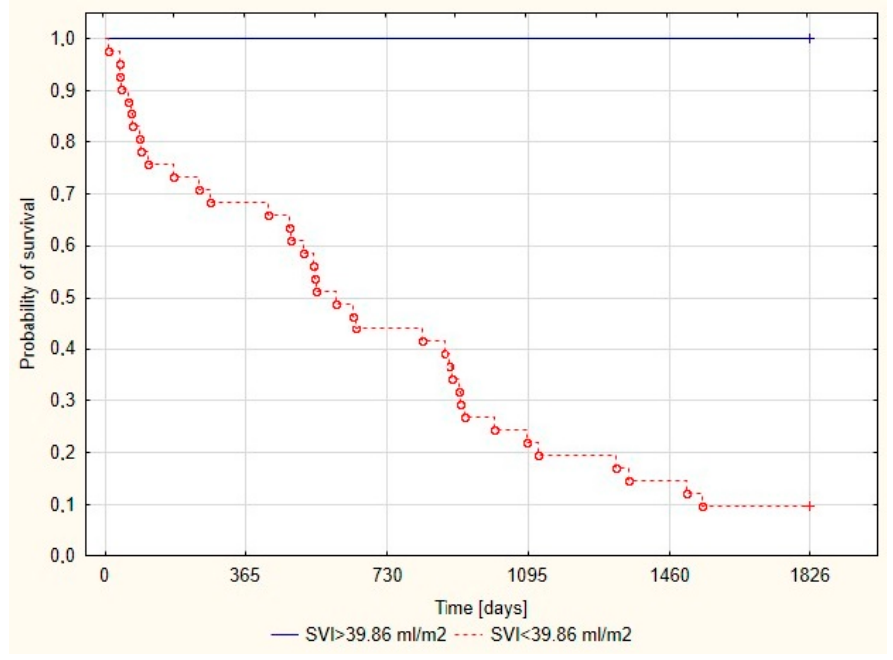
Figure 2. Probability of survival of time free of death or urgent lung transplantation depending on SVI value during iNO inhalation